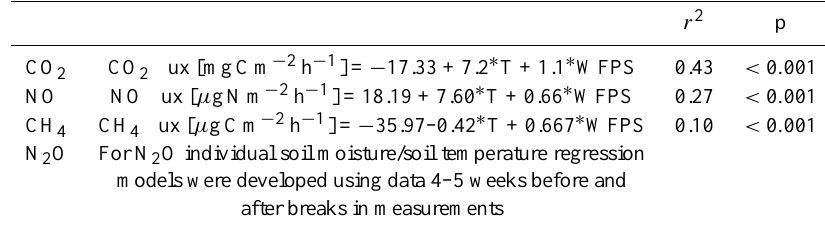
Table 2. Regressions used at daily time scale for gap-filling periods without